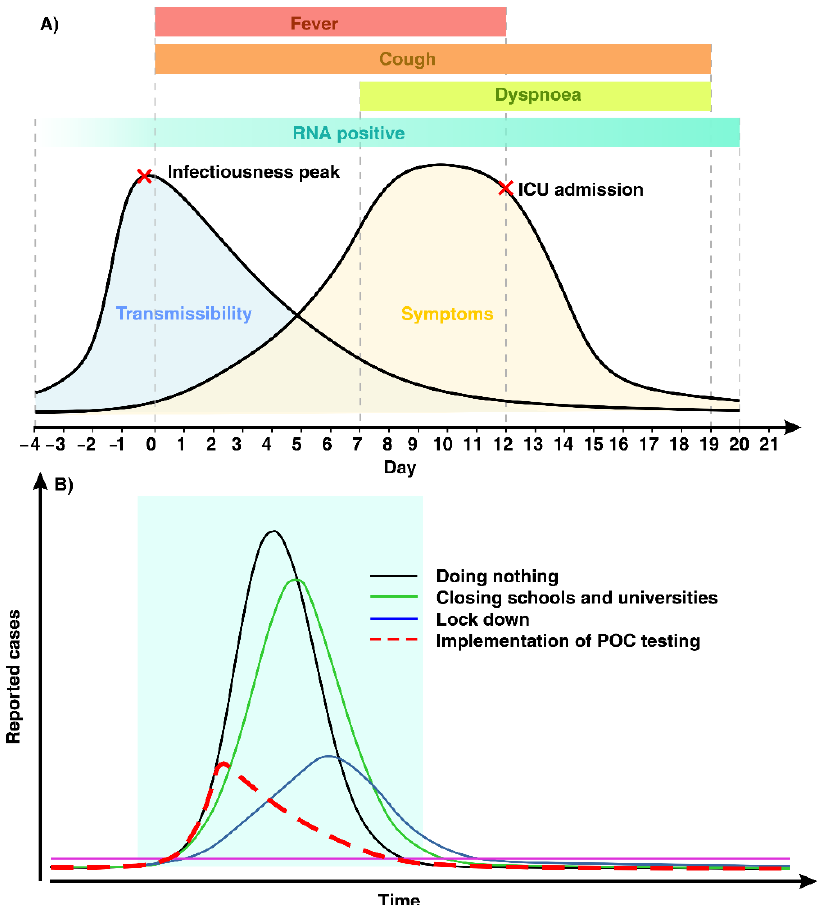
Figure 1. ( A ) Schematic illustration of symptoms and transmissibility of coronavirus disease 2019 (COVID-19). The clinical spectrum of COVID-19 is broad, including asymptomatic, mild, and severe. SARS-CoV-2 RNA is detectable prior to symptoms onset. Fever and cough are common symptoms of COVID-19 for the first days, followed by dyspnea eight days after first symptoms. Those who are at a higher risk of getting severe infection are referred to intensive care unit (ICU) admission usually after two weeks. ( B ) POC testing enables an increased screening and detection capacity in a cost-effective manner, which can aid a government to control the current and emerging